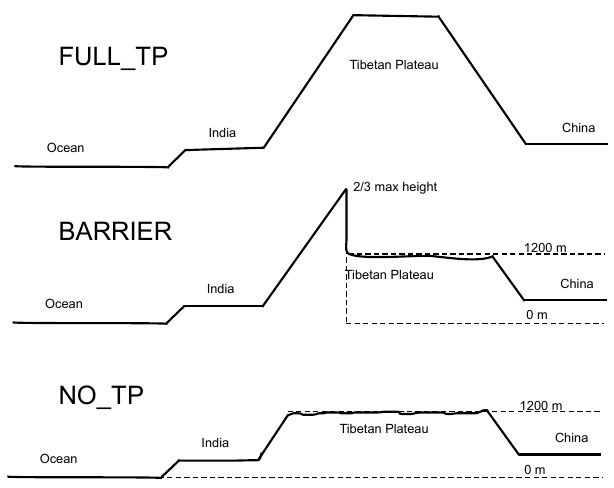
Figure 1. Schematic topographies used for the FULL_TP, BAR- RIER, and NO_TP experiments, respectively. The dashed lines of the elevation of 0m denote the topographies used in BK10’s exper- Figure1.SchematictopographiesusedforFULL_TP,BARRIER,andNO_TPexperiments,respectively. iments. Thedashedlinesoftheelevationof0meterdenotethetopographiesusedinBK10experiments.